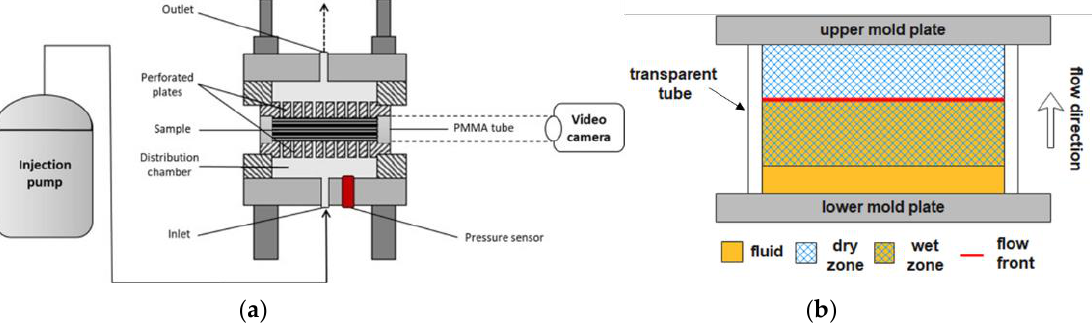
Figure 6. ( a ) Experimental set-up for concurrent out-of-plane unsaturated permeability and com- paction characterization and ( b ) an illustration of transverse flow front advancement and fiber-bed compaction ([62] Copyright (2021) with permission from Elsevier).